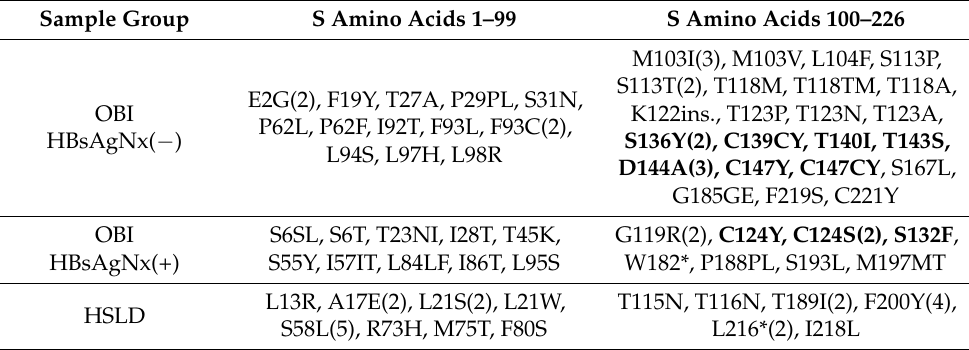
Table 6. S amino acid substitutions and deletions unique to OBI or HSLD samples.